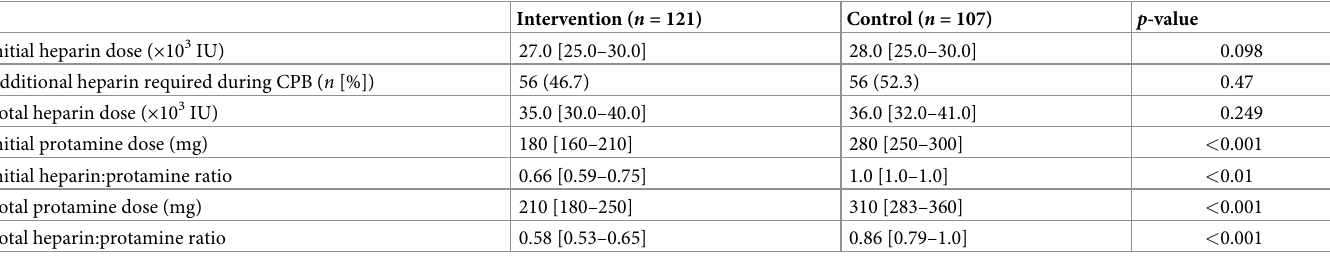
Table 2. Unfractionated heparin and protamine dosing of participants allocated to the intervention (PRODOSE model) and control (fixed 1:1 ratio) groups.